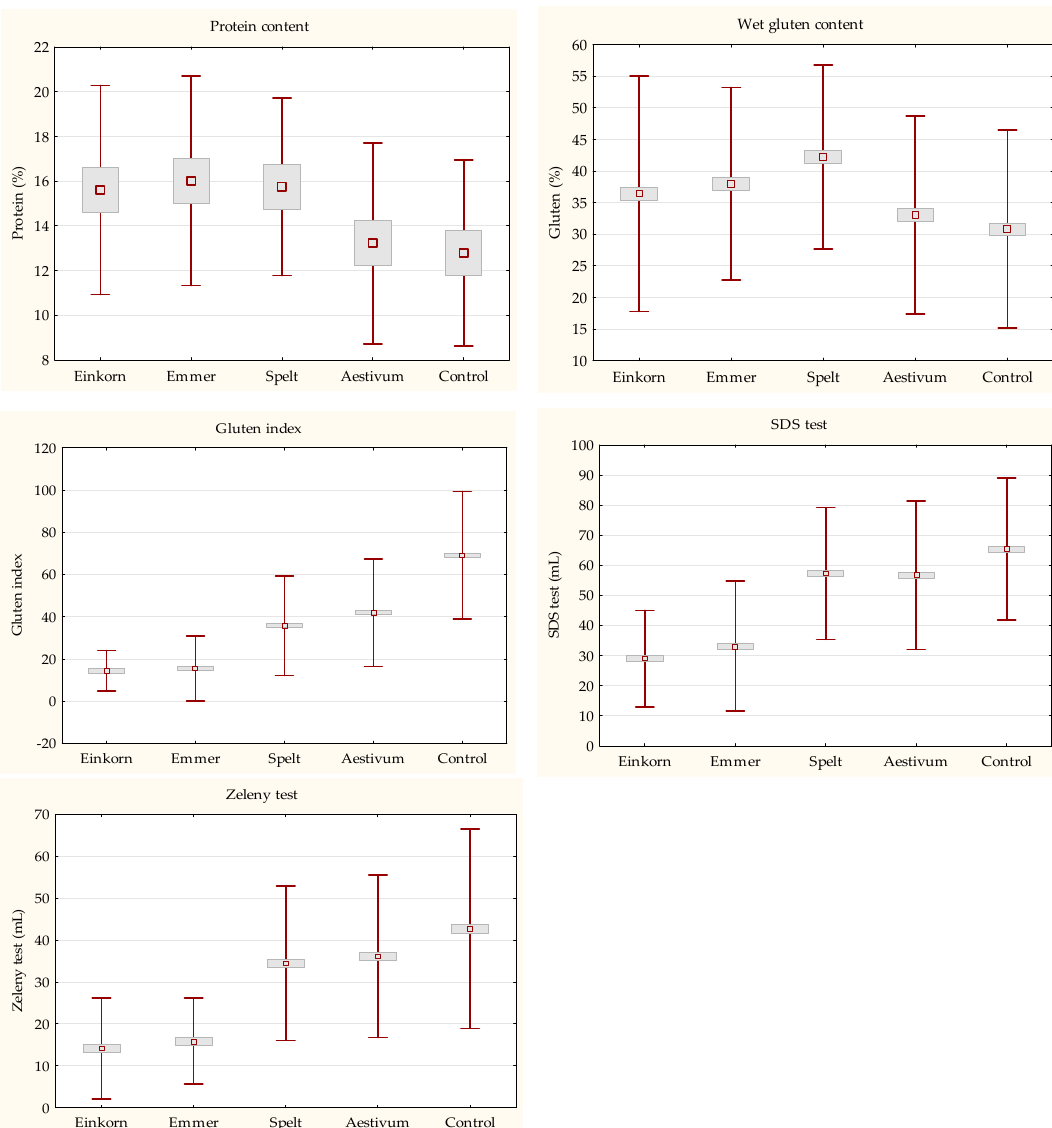
Figure 3. Contents of protein and gluten, gluten index, sodium dodecyl sulphate (SDS) test, and Zeleny test in einkorn, emmer, spelt, aestivum, and control varieties. Figures are presented as the mean of five wheat species grown at three locations, four replications, in four years ( n = 1248). Bbox plots represent the interquartile range, the rectangles in the box symbolize the mean value ±1, and whiskers designate minimum and maximum of the box plot.